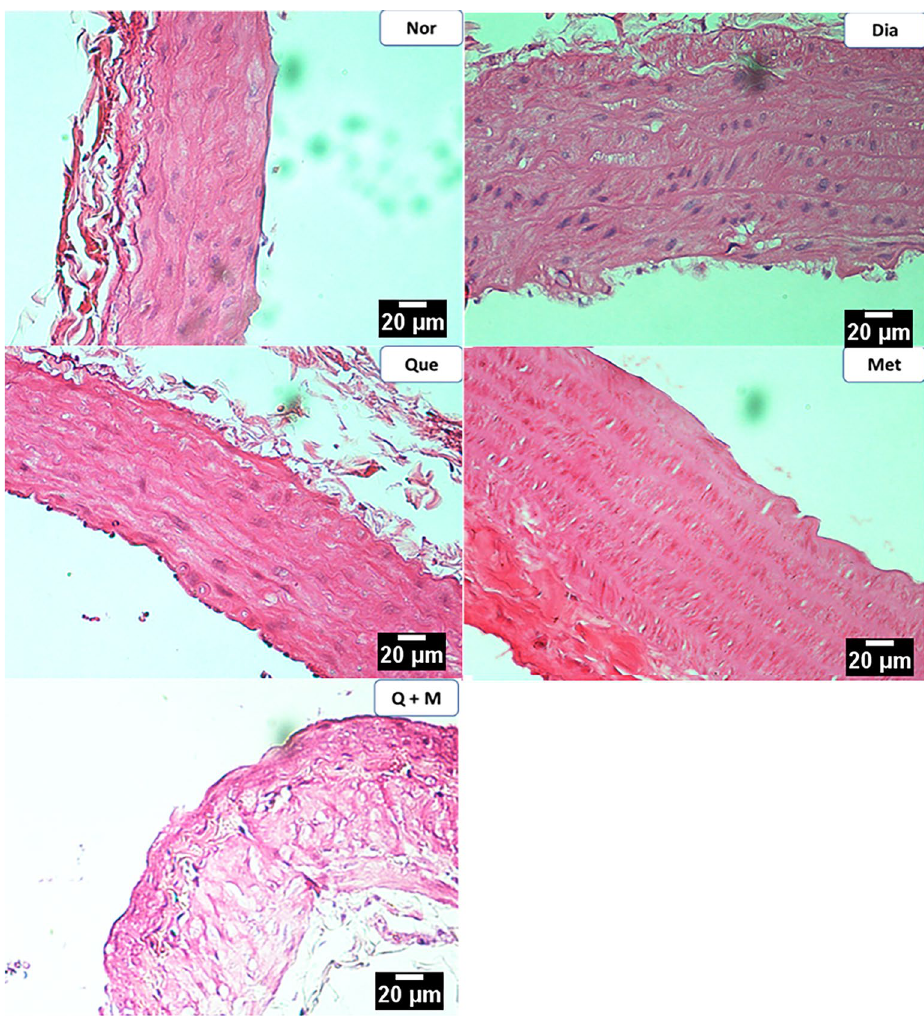
Figure 7. The effect of test compounds on abdominal aortae histology in diabetic rats. Nor Normal, Dia Diabetic, Que Quercetin treated, Met Metformin treated, Q + M Quercetin + metformin treated diabetic